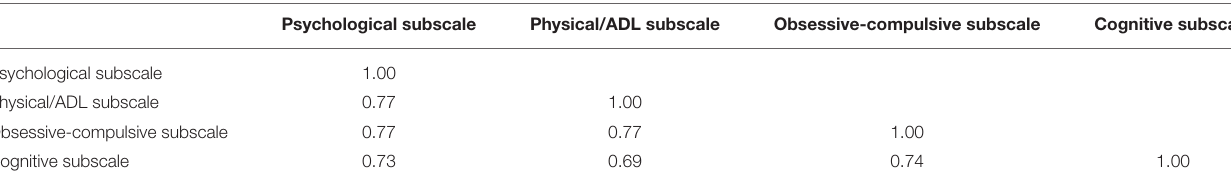
TABLE 3 | Interscale correlations of each